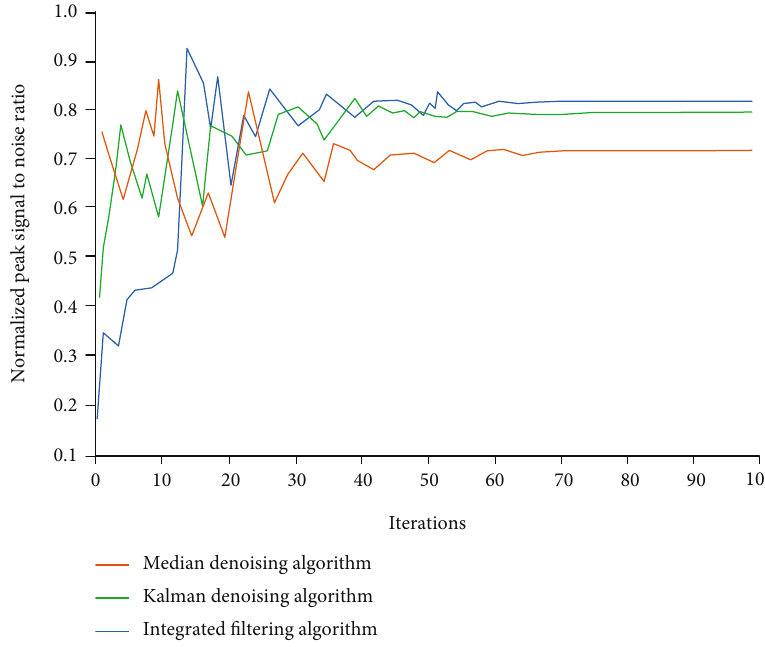
Figure 8: Statistical results of peak signal-to-noise ratio of each fi ltering